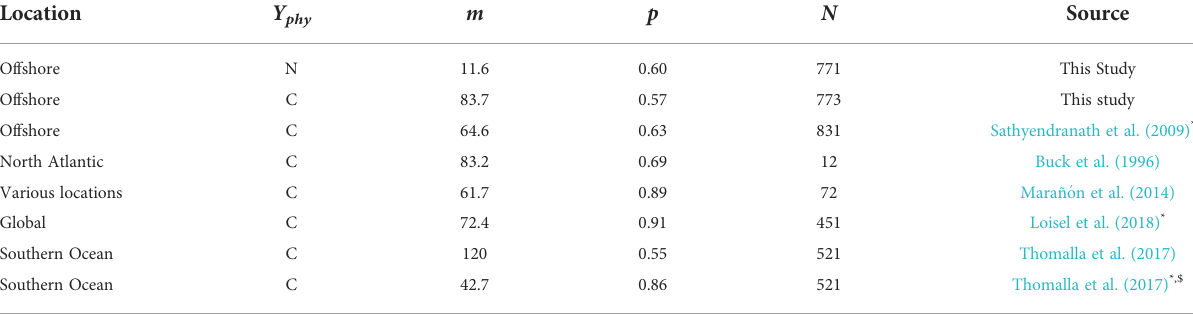
TABLE 1 Parameters of the power law relationship of carbon (C) and nitrogen (N) fi tted against chlorophyll-a.